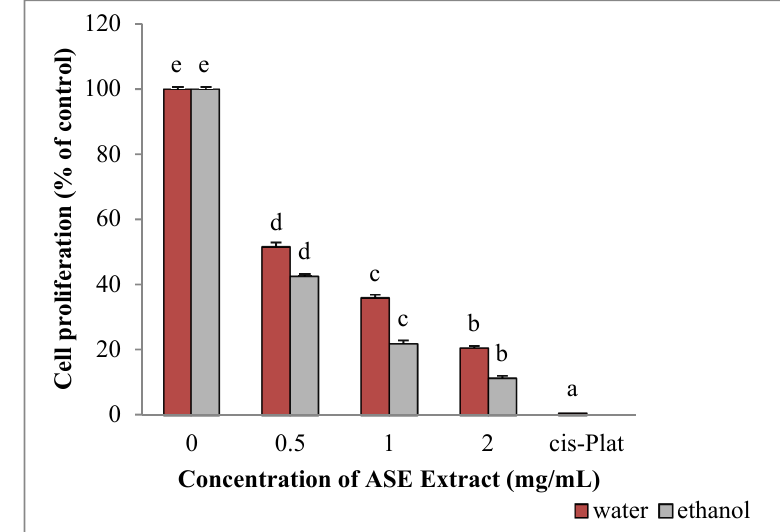
Figure 5. Effects of ASE crude extracts on MCF-7 cell proliferation (concentration 0 corresponding to the untreated group). Data are expressed as mean ± SD, n = 3. Bars marked by unlike letters within a group are significantly different at p<0.05, according to Duncan’s Multiple Range Test (DMRT).